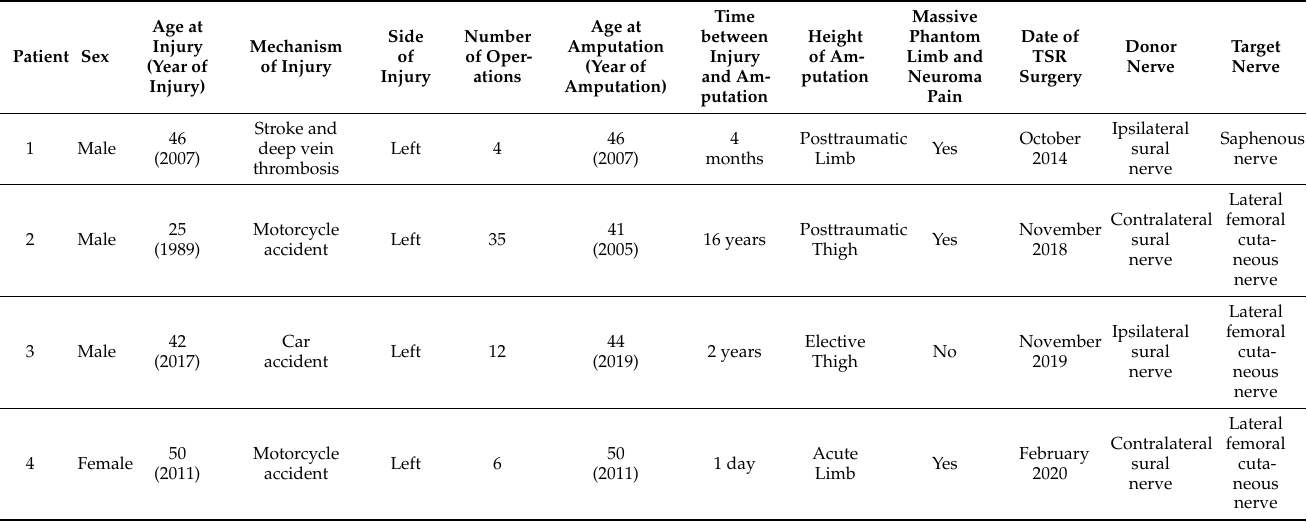
Table 1. Summary of patients and their pre-operative